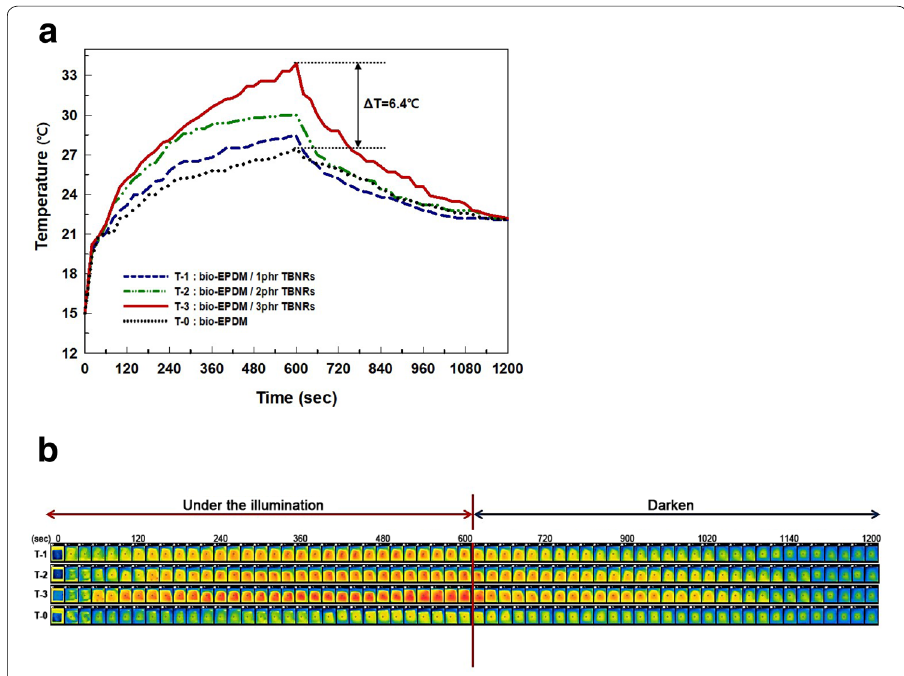
Fig. 7 Temperature variation profiles ( a ) of bio‑EPDM foam with TBNRs and NIR images ( b ) under white light irradiation for 10 min and after turning off the light for the following 10